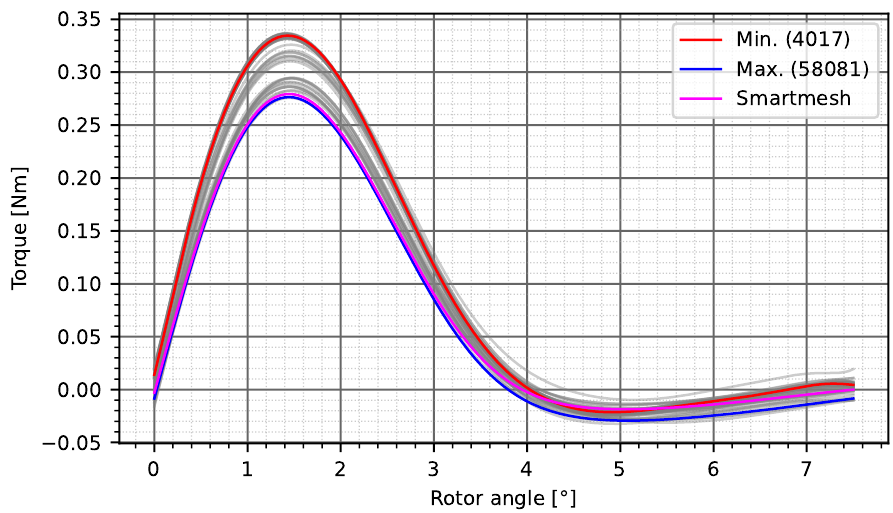
Figure 9. Cogging torque in relation to different mesh settings. The labels show the total number of elements in a particular configuration. In magenta, the smart mesh option was turned on.